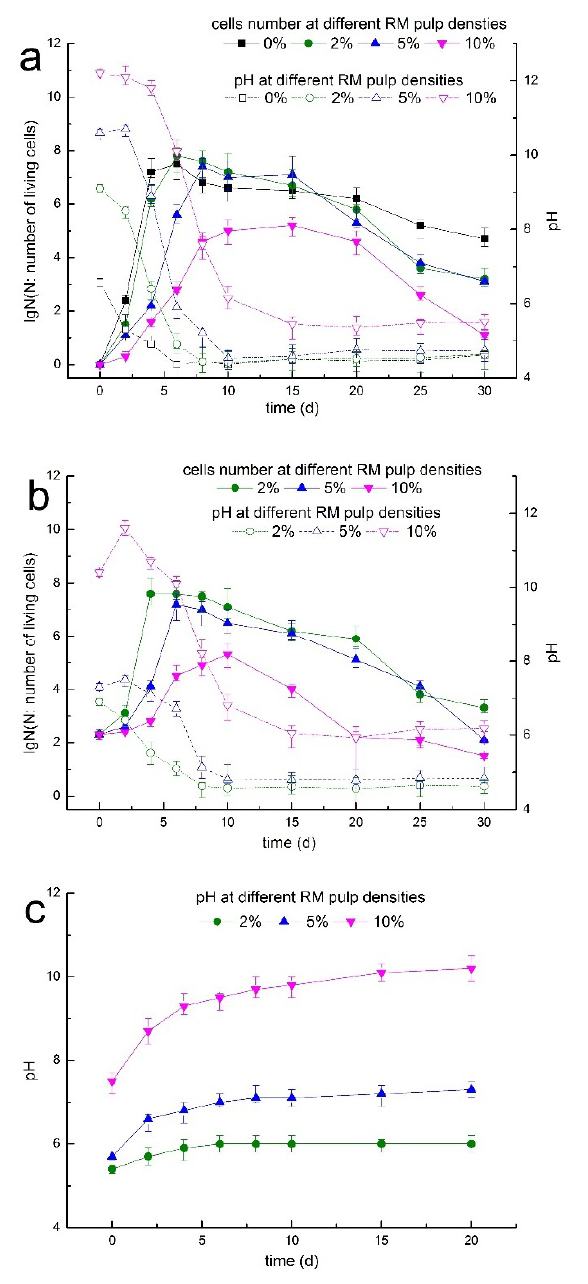
Figure 2. Variation of the number of living cells (solid line) and pH value (dashed line) under ( a ) one-step process, ( b ) two-step process, and ( c ) spent medium process at 2%, 5%, and 10% RM pulp desities. (N on the left y -axis refers to total number of living cells).